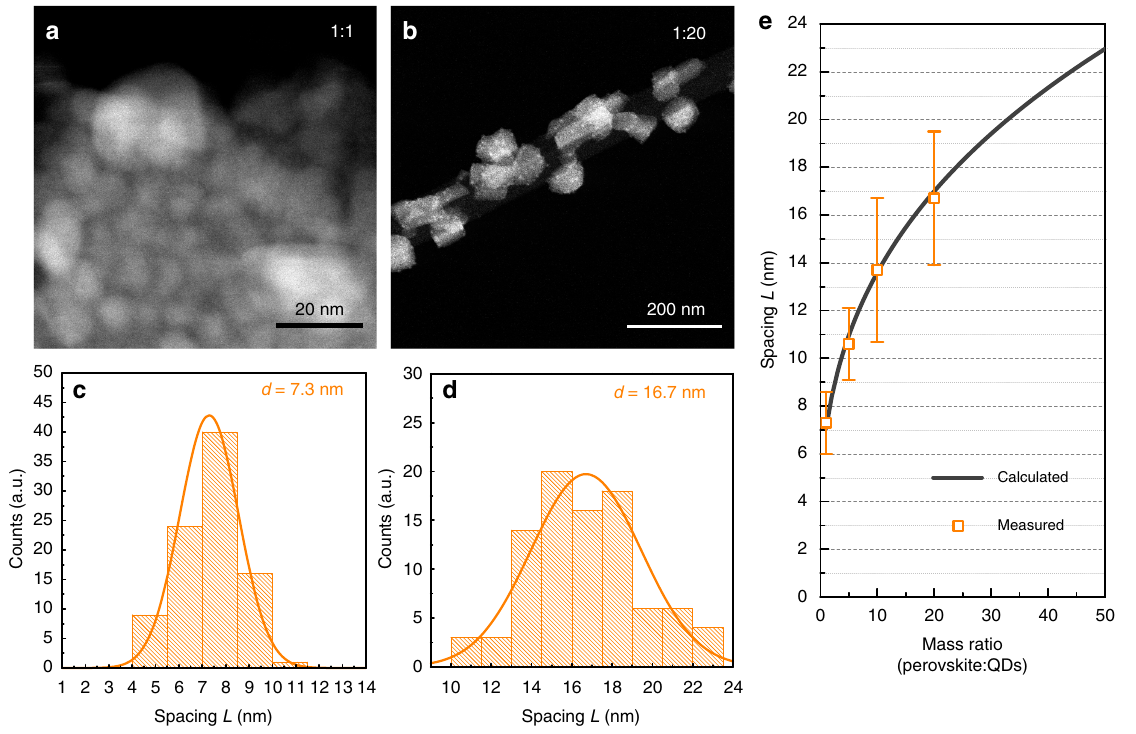
Fig. 3 Diffusion distance ( L ) extraction. a , b STEM images of quantum dots (bright dots) in perovskite single crystals with the mass ratio between QDs and perovskite of 1:1 and 1:20. With the decreasing QD concentration, the inter-dot spacing increases. c , d Statistic distribution of L from over 90 data points from the STEM images. e Calculated L as a function of QD concentration (grey line), and experimental data (yellow points). The error bars indicate standard deviation of the measured